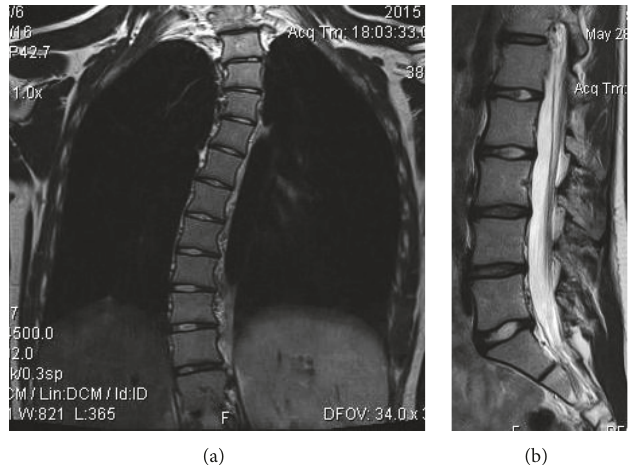
Figure 4: A 16-year-old female with thoracolumbar scoliosis. (a) Degree of scoliosis is appreciated on the coronal T2WI. (b) There is mild diffuse disc bulge and moderate degenerative disc changes at the L3-4 and L4-5 level, as well as moderate disk bulge at L5-S1 level, on the sagittal T2